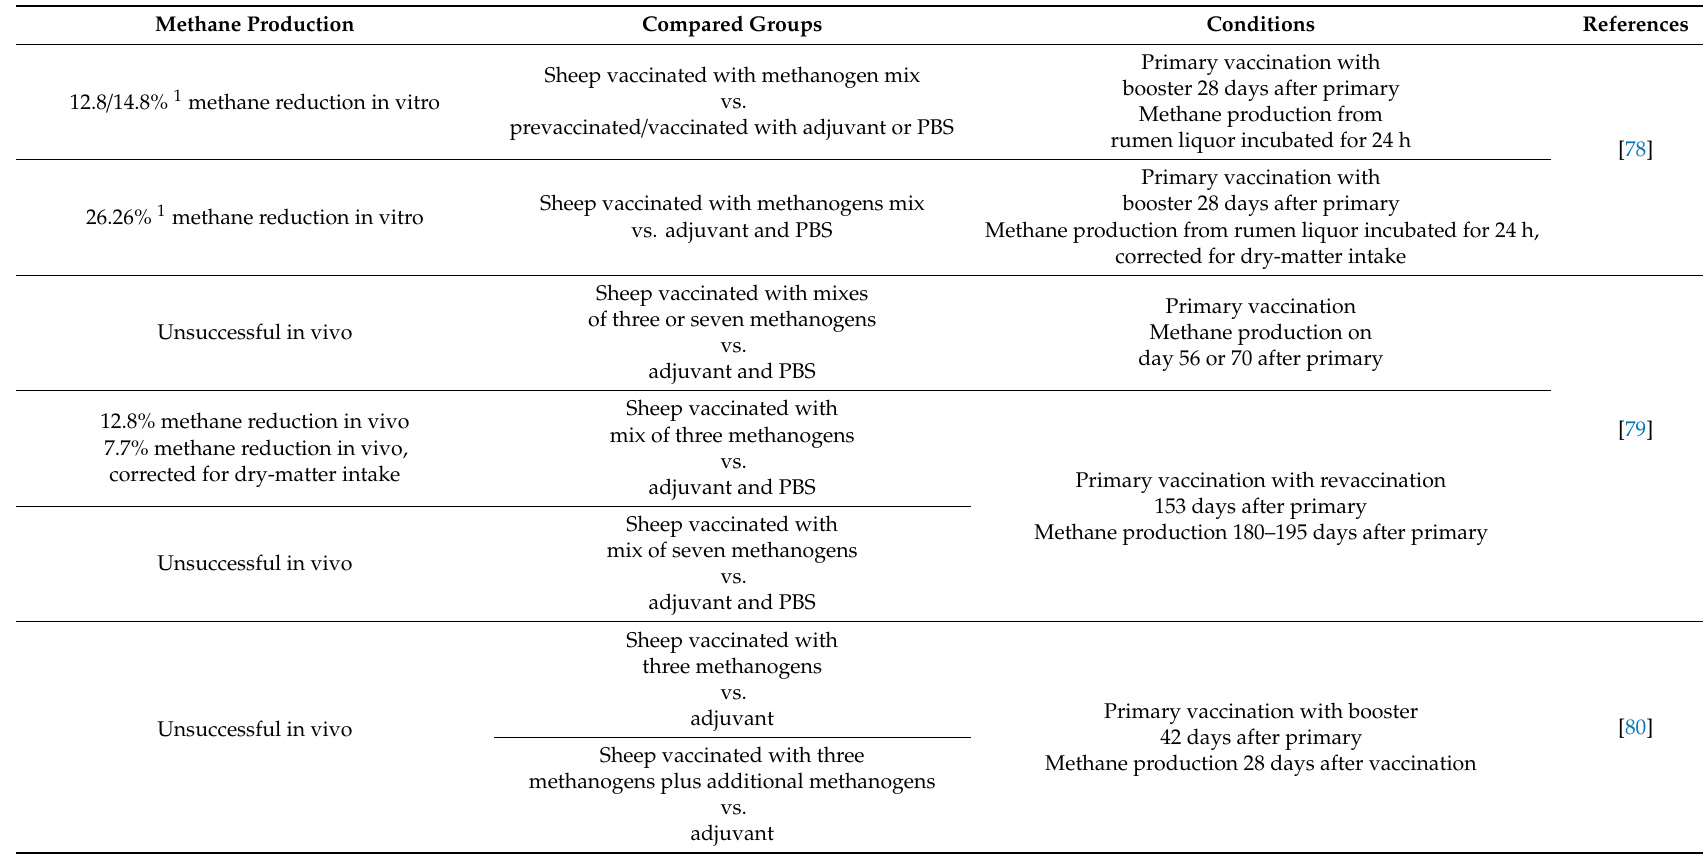
Table 3. E ff ect of research into vaccinating ruminants on methane